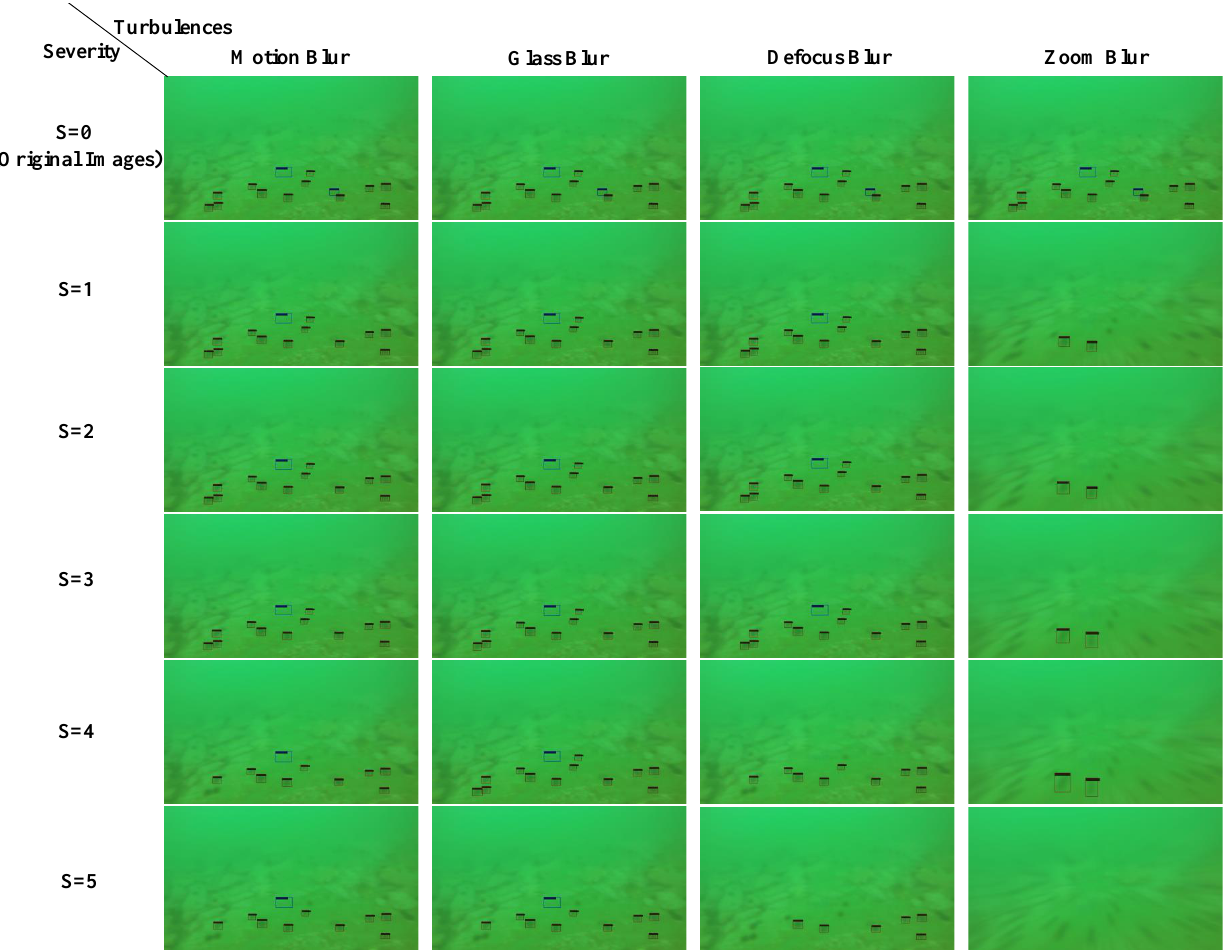
Figure 13. Visualization of the model’s image detection results for different levels of noise severity in the scenario of four types of blurred noise that may be caused by movement. In the figure, S represents the same meaning as in Figure 12. In contrast to the previous figure, we use four different kinds of blurred noise